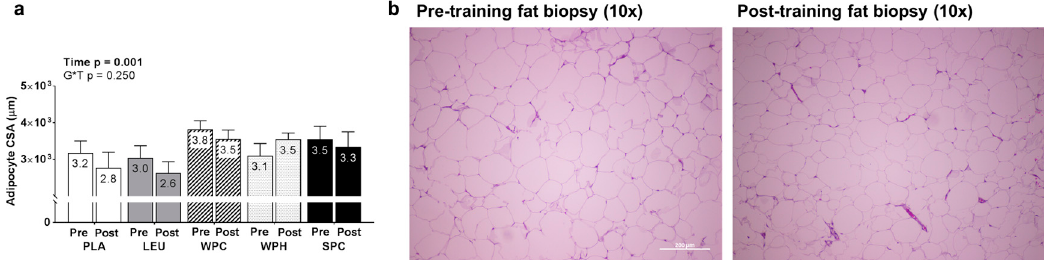
Figure 6. Changes in gluteal subcutaneous adipocyte cross sectional area between groups. Legend: Pre- and post-training subcutaneous adipocyte cross sectional area (CSA) values are presented in ( panel a ). Representative 10x objective histology images from one subject demonstrating a reduction in fat cell size is presented in ( panel b ). Due to poor tissue quality on select subjects, n-sizes were as follows: PLA n = 14, LEU n = 12, WPC n = 14, WPH n = 10, and SPC n = 13. The bar graph depicts group averaged data presented as mean + standard error values, and mean values are presented within each bar. Abbreviations: PLA, maltodextrin placebo; LEU, L-leucine; WPC, whey protein concentrate; WPH, whey protein hydrolysate; SPC, soy protein concentrate.